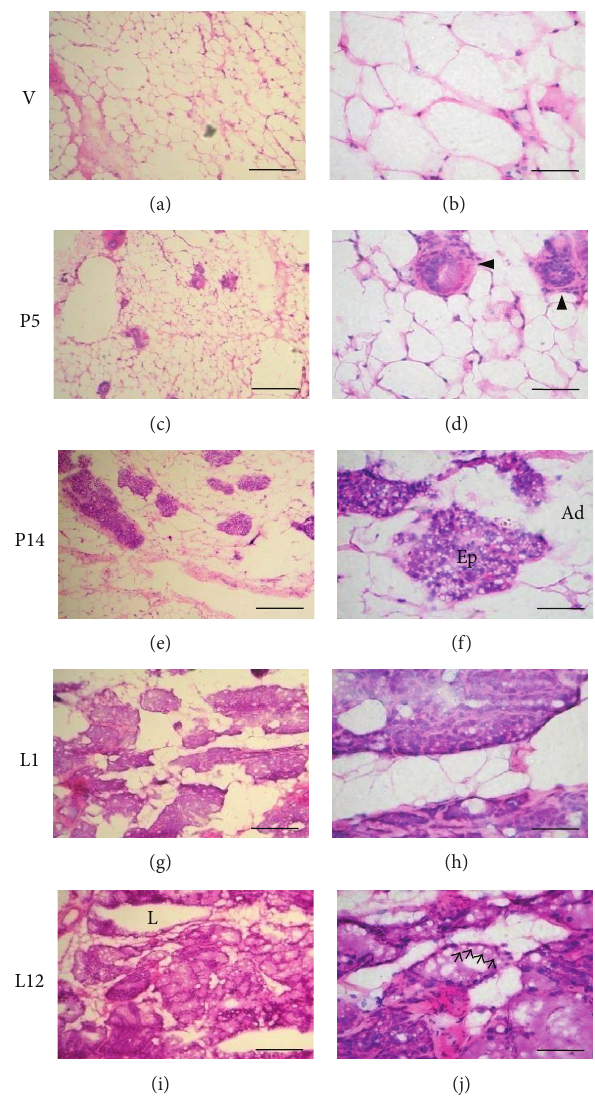
Figure 1: Histological features of the mammary gland from rats during pregnancy and lactation. Mammary glands were isolated from Sprague Dawley rats in (a, b) a nonpregnant virgin (V) stage; (c, d) day 5 (P5) and (e, f) day 14 (P14) of pregnancy; and (g, h) day 1 (L1) and (i, j) day 12 (L12) of lactation, cryosectioned, and stained with hematoxylin and eosin. Scale bars in (a), (c), (e), (g), and (i) = 50 𝜇 m, whereas those in (b), (d), (f), (h), and (j) = 10 𝜇 m. Adipose compartment (Ad), lobuloalveolar units ( 󳵳 ), epithelial compartment (Ep), luminal structures (L), and milk globules ( ↑